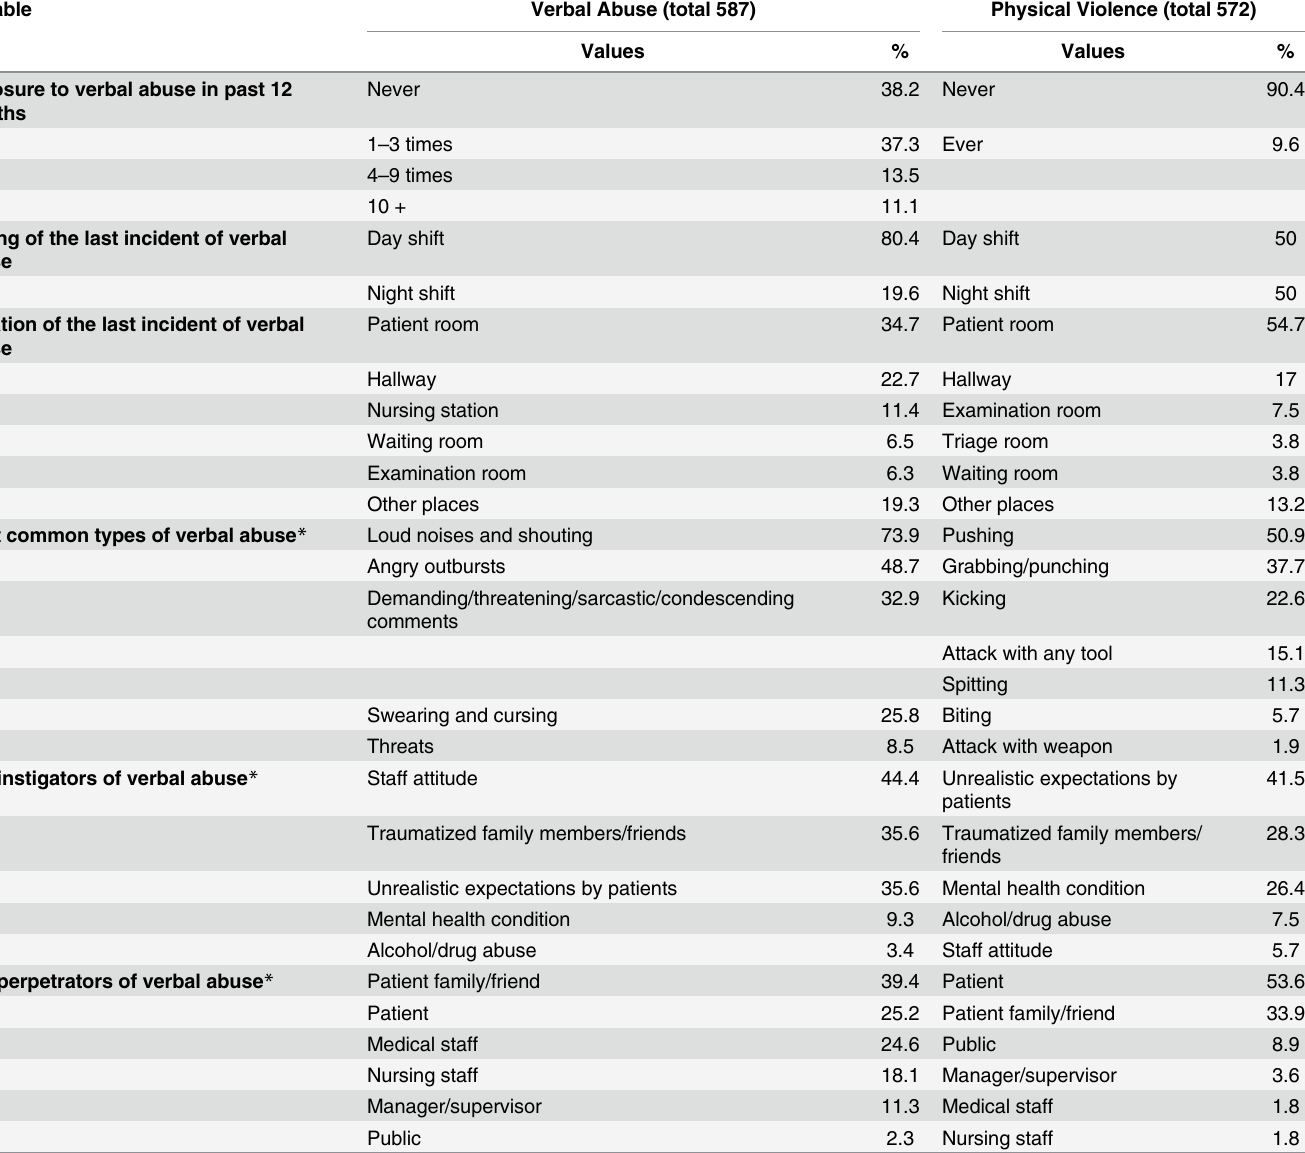
Table 2. Nurses' exposure to and characteristics of verbal abuse and physical